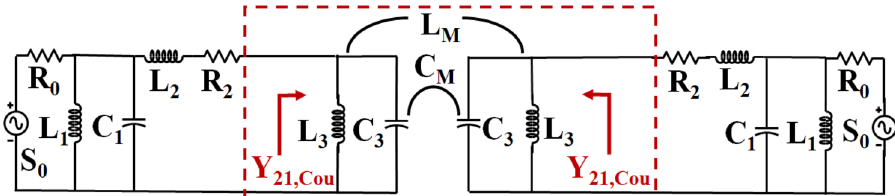
Figure 4. Matching passive circuit configuration of the MIMO (M-shaped)